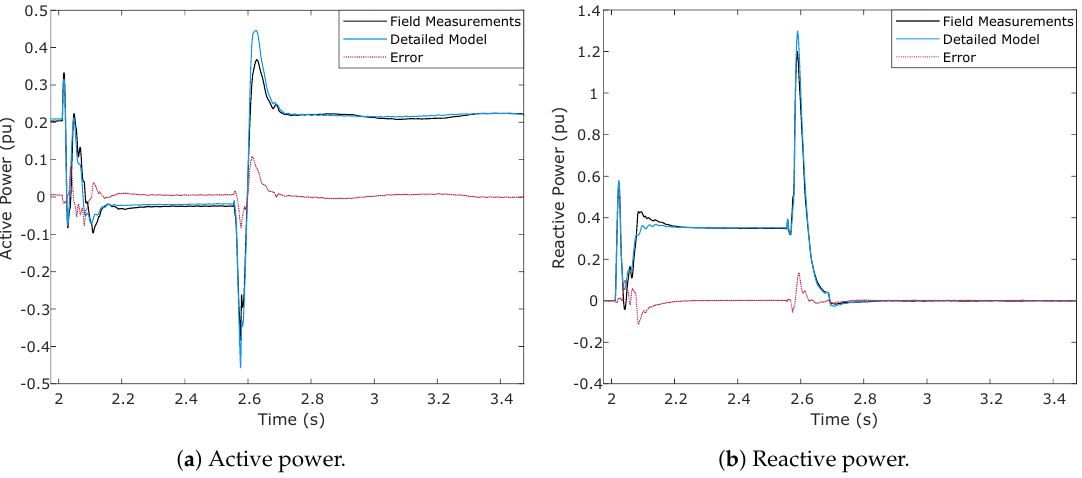
Figure 3. Active and reactive power comparison between the field measurements and the simulation responses of a Siemens Gamesa G52 WT under a voltage dip with WT operating at partial load